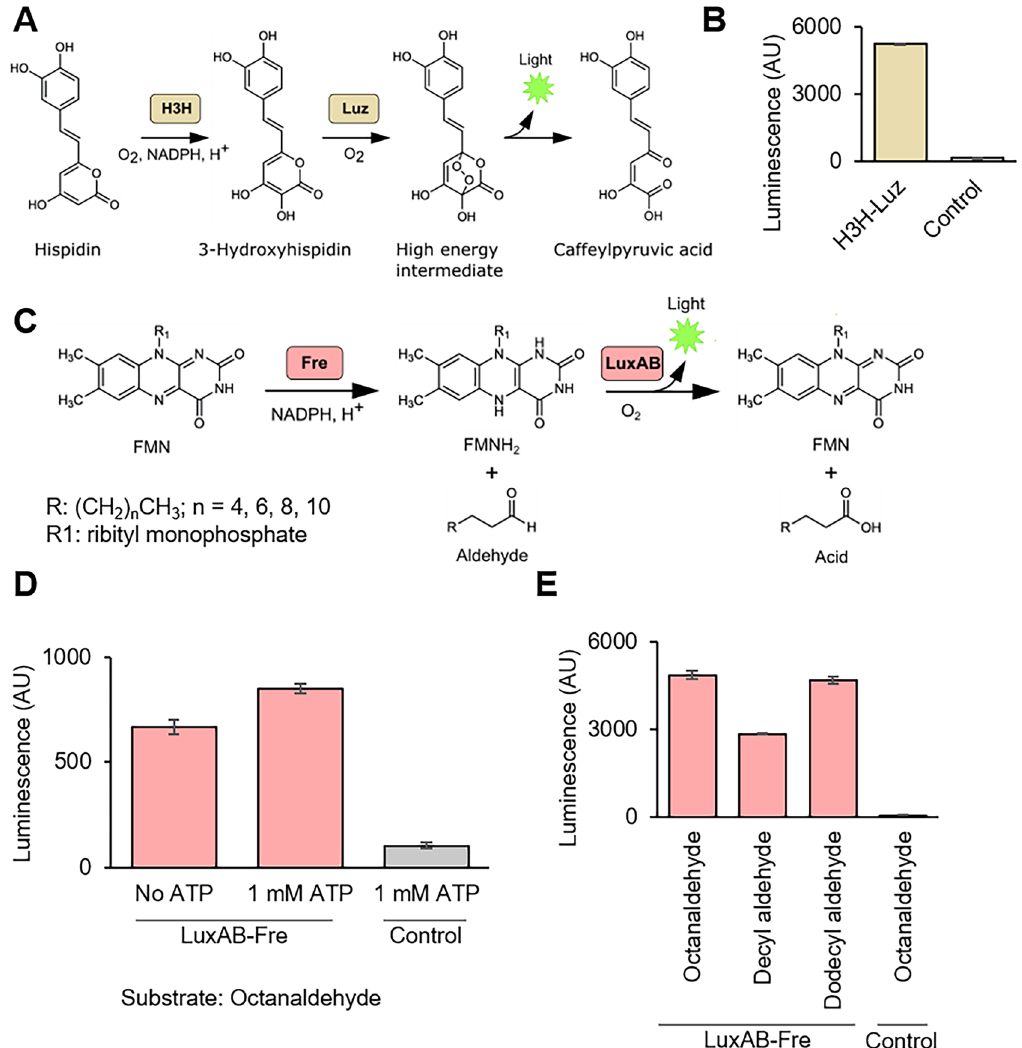
Figure 1. Characterization of H3H-Lux and LuxAB-Fre luciferase systems in TXTL. ( A ) Schematic of H3H- Luz luciferase reaction. Hispidin is converted to 3-hydroxyhispidin by hispidin-3-hydroxylase (H3H) and 3-hydroxyhispidin is oxidized and converted into a high energy intermediate by the luciferase (Luz). This intermediate decays into caffeylpyruvic acid with light emission. ( B ) The H3H-Luz luminescence measurement. H3H and Luz were expressed in TXTL. The luminescence was measured right after adding NADPH and hisipidin into the TXTL. ( C ) Schematic of LuxAB-Fre luciferase reaction. Oxidized flavin mononucleotide (FMN) is reduced into reduced flavin mononucleotide (FMNH 2 ) by NAD(P)H-flavin reductase (Fre). The luciferase (LuxAB) converts FMNH 2 and long-chain aldehydes into FMN and the corresponding long-chain acids with light emission. ( E ) ATP supplementation increased the light emission of LuxAB-Fre. Octanaldehyde was added as the substrate. ( D ) The LuxAB-Fre luminescence measurement with different long-chain fatty aldehydes. LuxA, LuxB and Fre were expressed in TXTL. The luminescence was measured right after adding FMN, NADPH, ATP, and substrates (octanaldehyde, decyl aldehyde, and dodecyl aldehyde.) NADPH, nicotinamide adenine dinucleotide phosphate; ATP, adenosine triphosphate; Control, reaction without enzyme expression. The graphs show means with error bars that signify SEM (n =